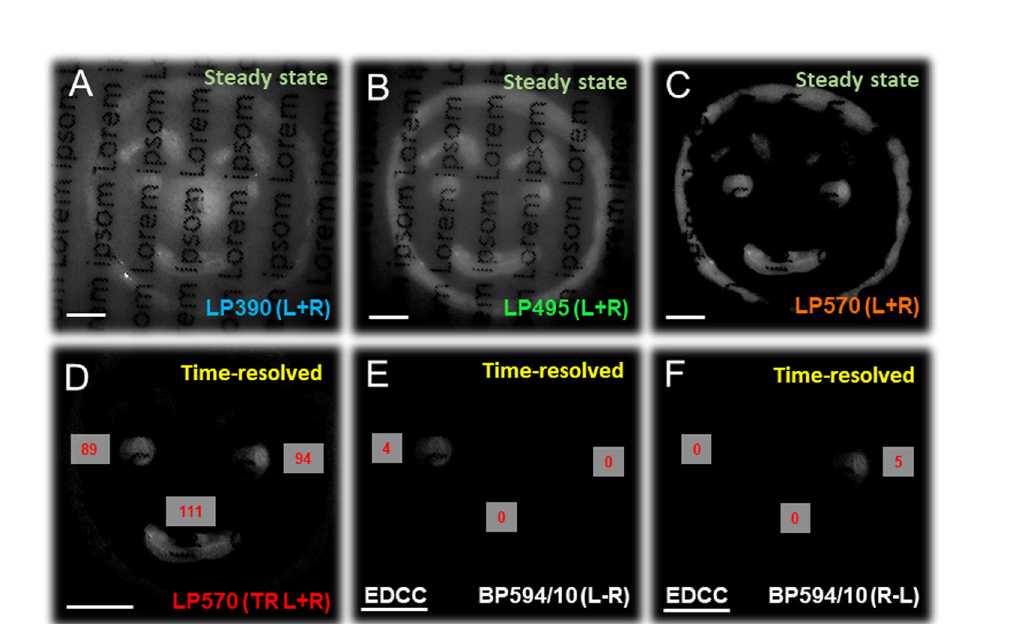
Fig.6|DesignandcompositionofthePOCCSIsecuritytag.A Schematicsofthe fl uorophorecompositionand UV (365nm,standard document reader)illuminated actual image of the concept invisible rudimentary Chameleon (CSI) security tag, scale bar 1cm. B Individual emission spectra of the CSI ’ s luminophores, high- lighting thecolourcodedemission fi ltersusedforrevealing fi vetiersofembedded securityfeatures. C Detectionmethodologyandproposed CPLPimagingsequence